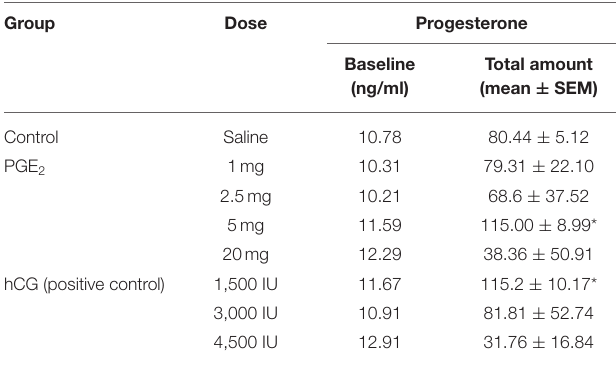
TABLE 1 | The effect of one intrauterine administration of prostaglandin (PG) E 2 or human chorionic gonadotropin (hCG; positive control) on progesterone (P 4 ) concentrations in mares’ blood plasma samples ( n = 3 per dose) at day 10 of the estrous